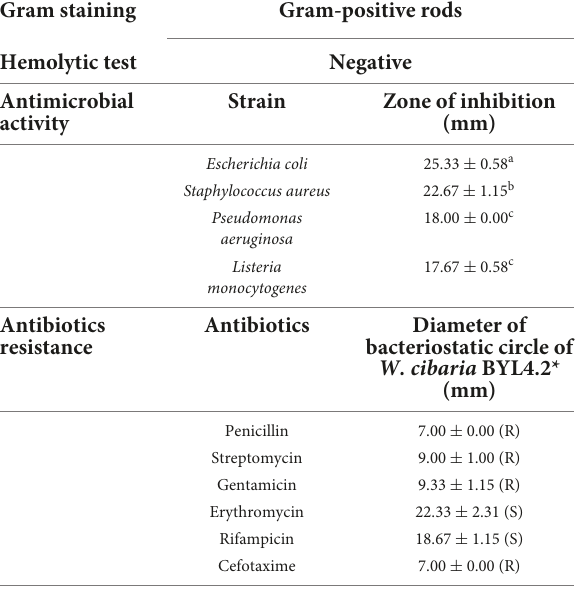
TABLE 1 The probiotic properties of Weissella cibaria BYL4.2. Gram